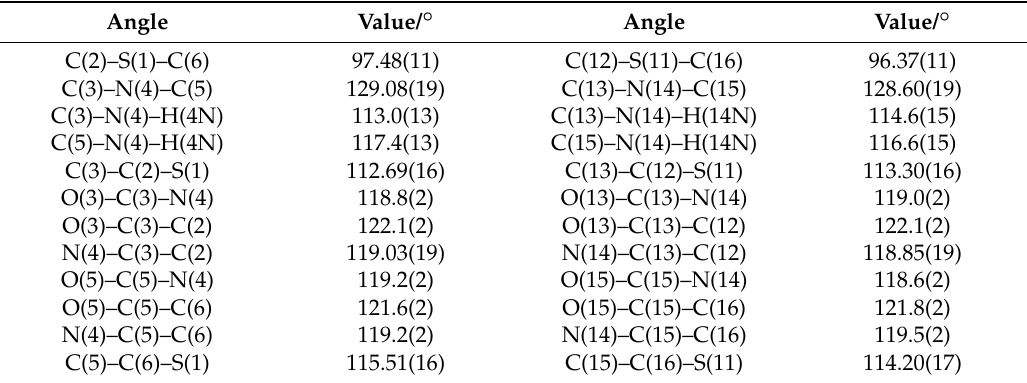
Table 2. Selected